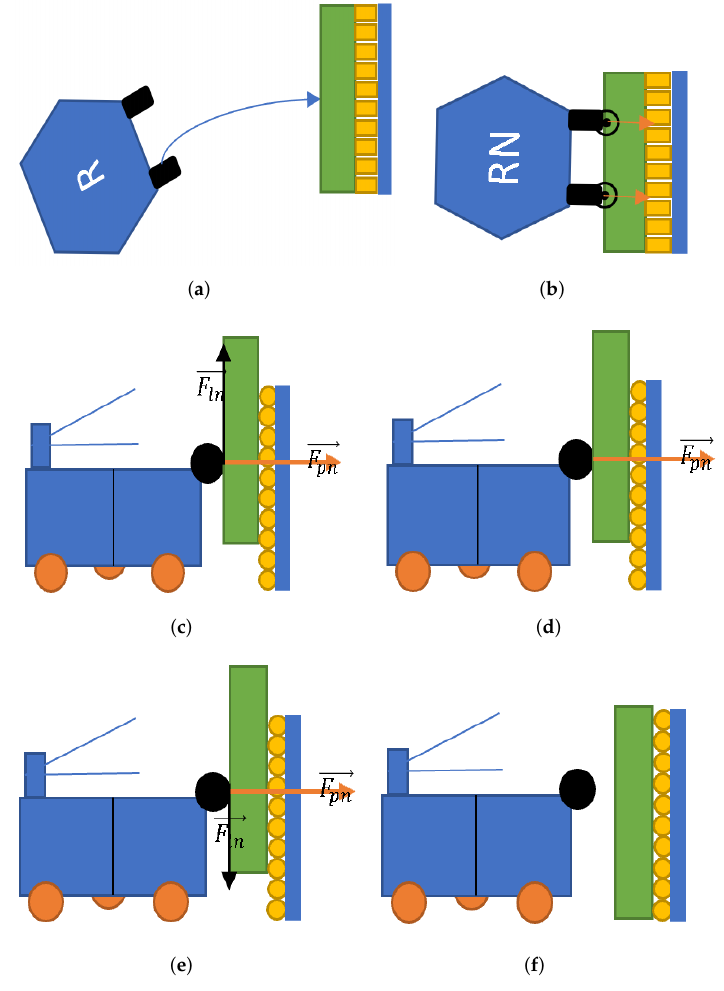
Figure 7. Execution stages: ( a ) approach; ( b ) press; ( c ) lift; ( d ) hold; ( e ) set down; and ( f )